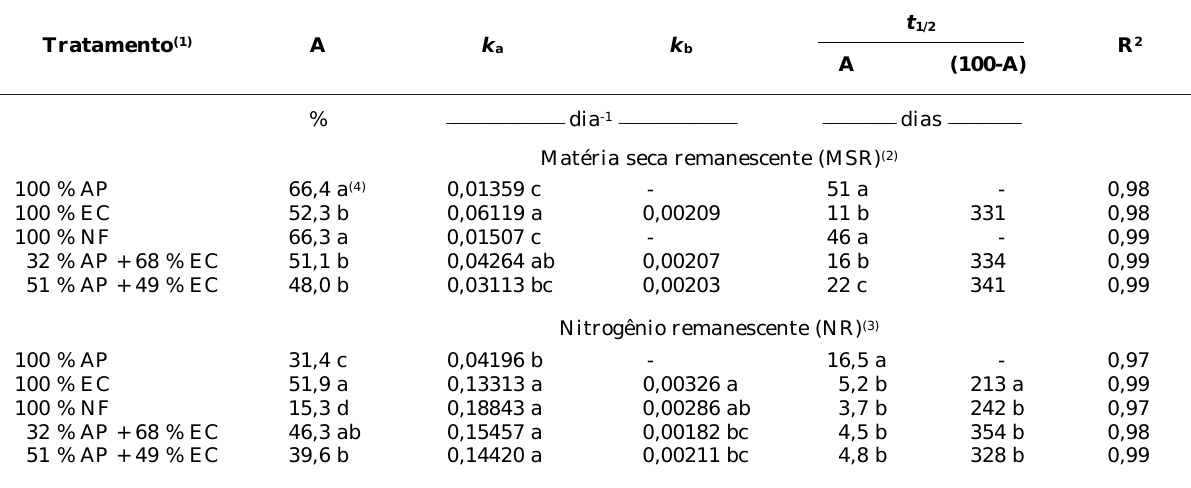
Quadro 5. Parâmetros dos modelos ajustados aos valores medidos de matéria seca e nitrogênio remanescente, tempo de meia vida ( t ) de cada compartimento e valores de R 2 em cada 1/2